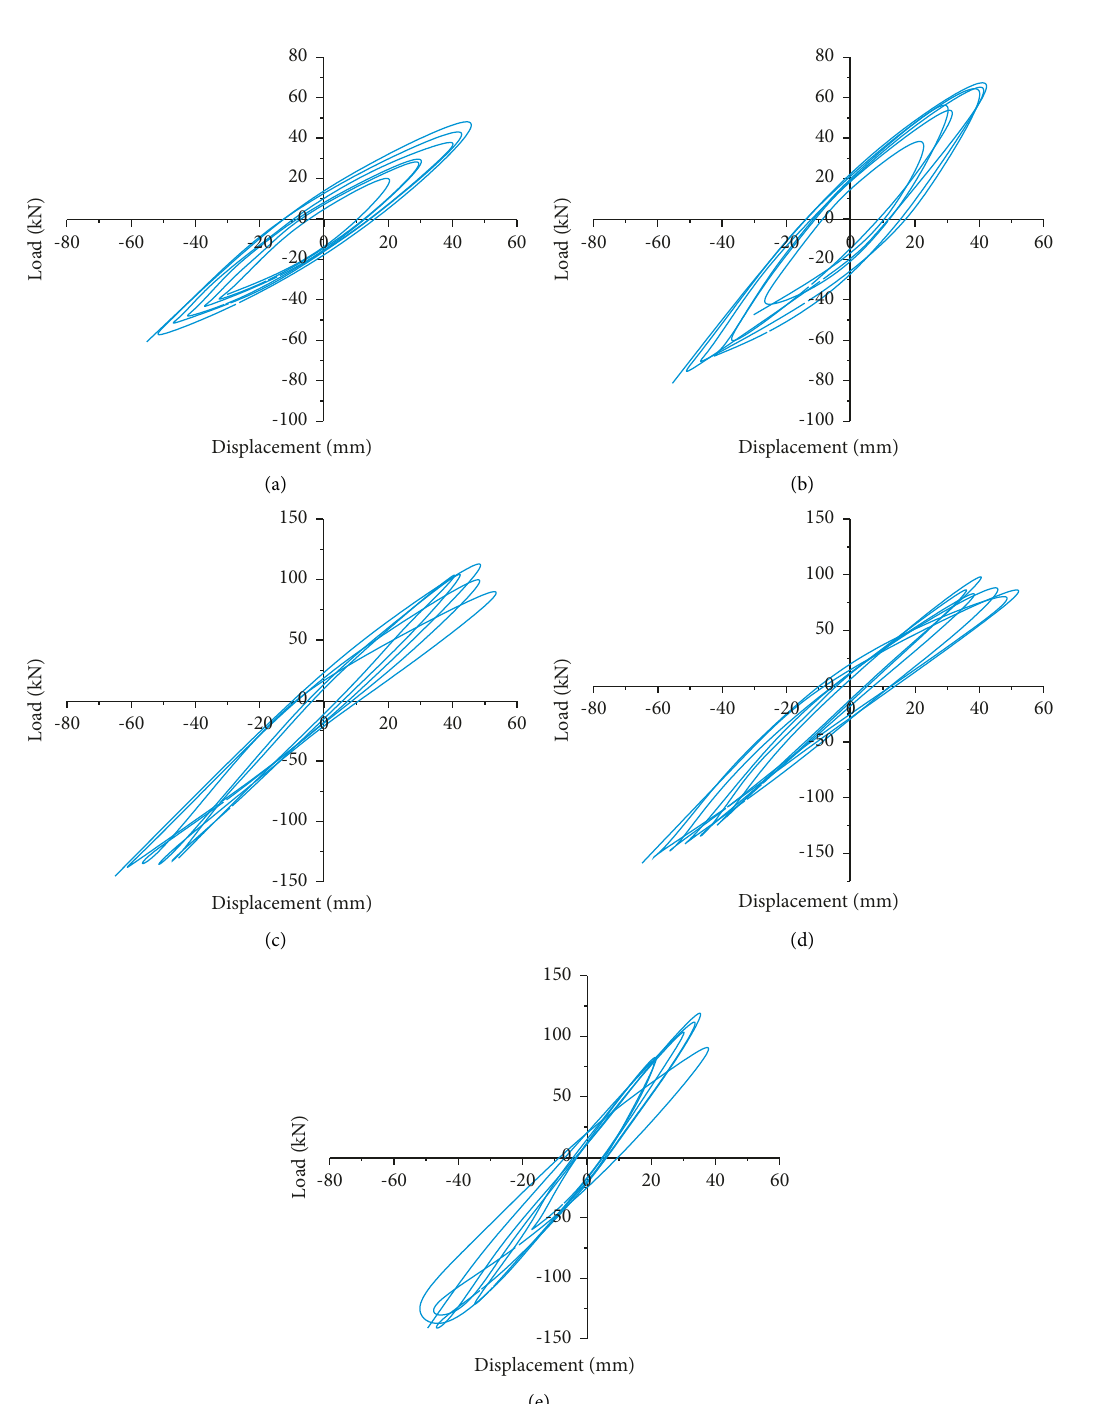
Figure 19: Hysteretic curves of joints with different sleeve thicknesses. (a) t � 6, (b) t � 8, (c) t � 10, (d) t � 12, and (e) t �